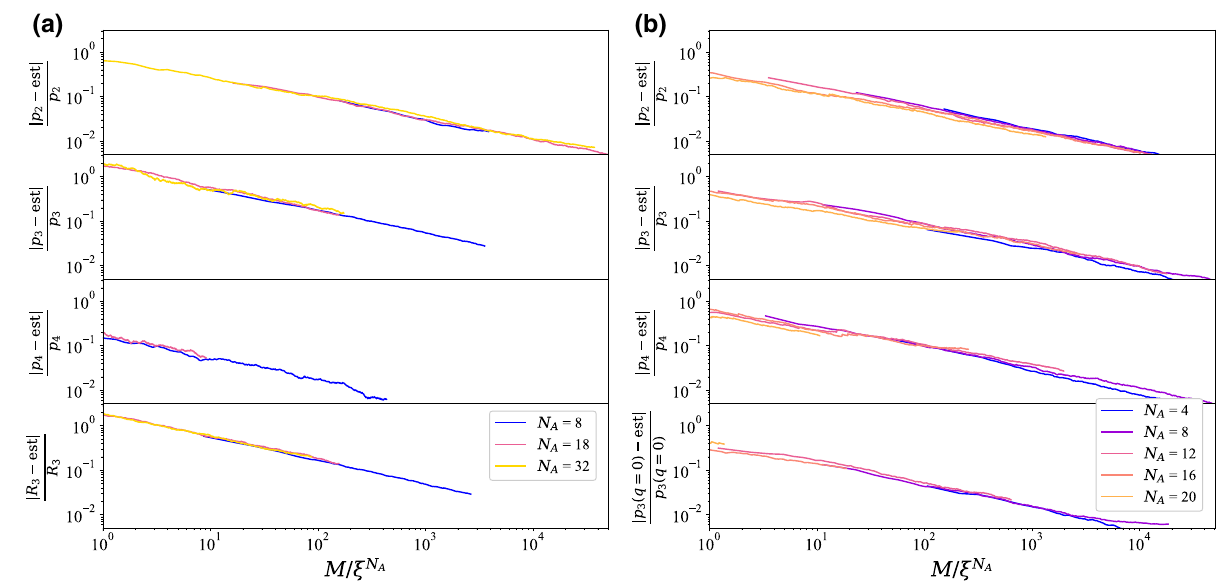
FIG. 7. Relative error in the estimation of (a) the second to fourth RDM moments and the third PT moment of the toric code ground state for a checkerboard partition ( N A = w 2 / 2), and (b) the second to fourth RDM moment and the third symmetry-resolved RDM moment for q = 0 of the XX model ground state, based on Eq. (23) for the RDM moments, on Eq. (25) for the PT moment, and (51) for the symmetry-resolved moment. Here, we use the partial-basis distribution, Eq. (29). The normalization of M by the scaling factor ξ n in the horizontal axis is extracted from Fig. 8 and presented in Table I in Sec. IV C. The presented plots are averaged over 20 different permutations of the estimation